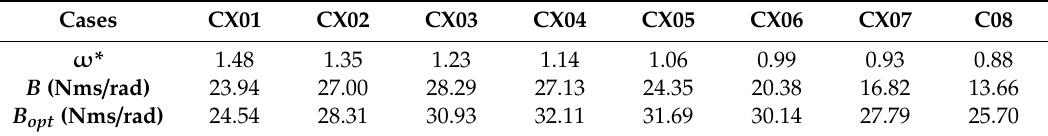
Table 4. Damping coe ffi cients for each wave frequency of the study.